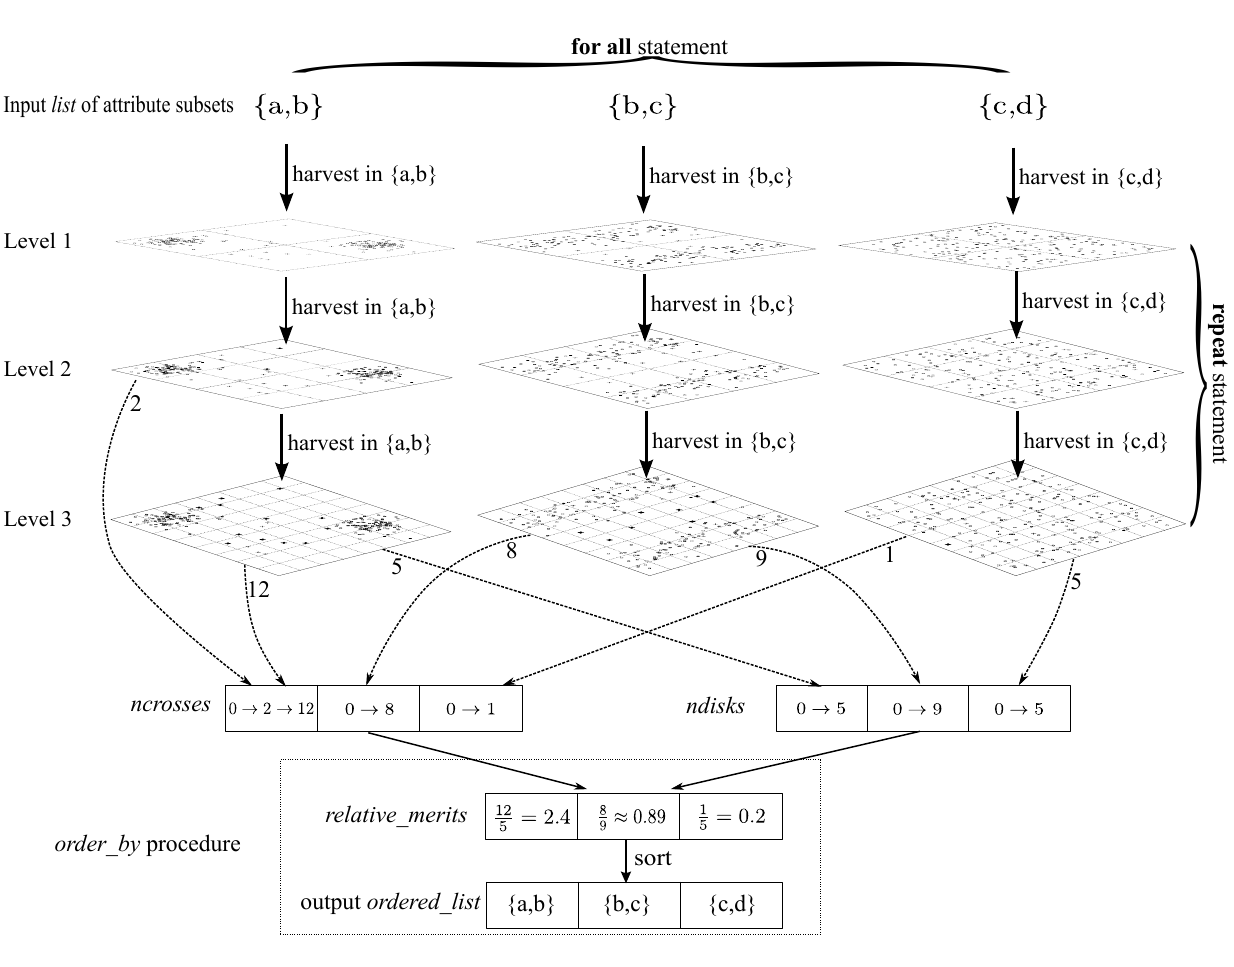
Figure 15. The “big” structure of harvest algorithms, where “ overwritten by . . .